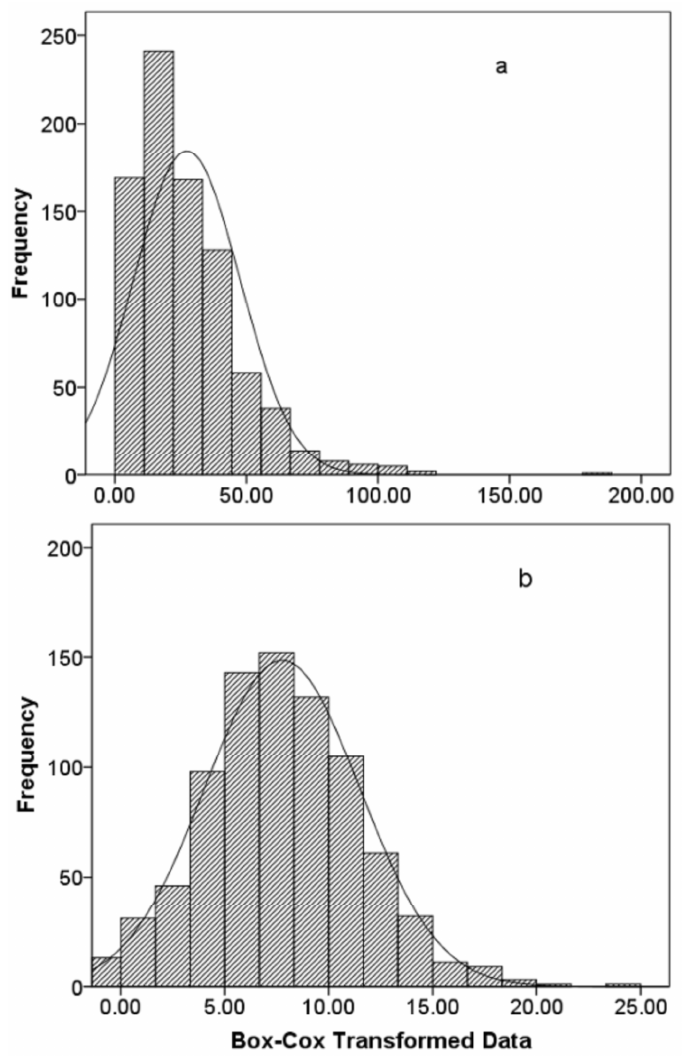
Figure 2. Histograms of forest biomass carbon (FBC) density: ( a ) raw data; ( b ) Box-Cox transformed data with normal distribution